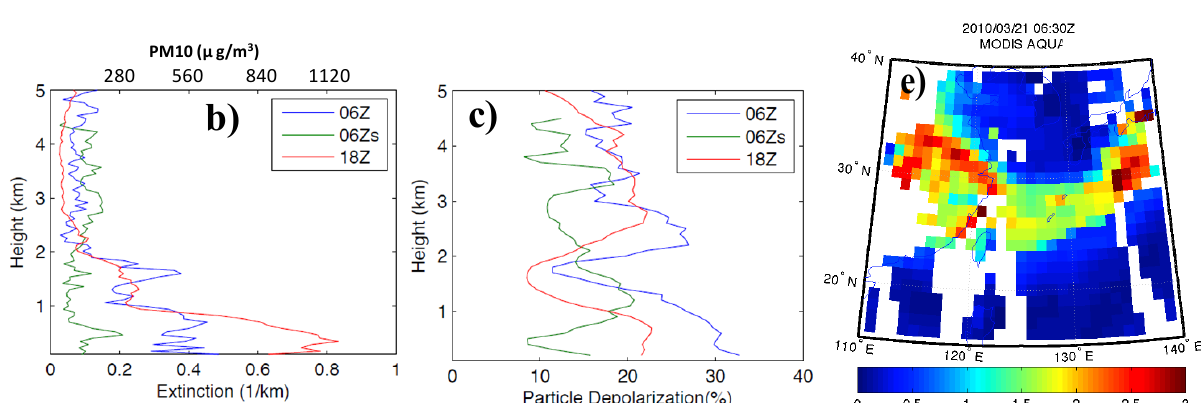
Hunchun (HC) station, was only about 132 µg m − 3 (Figs.